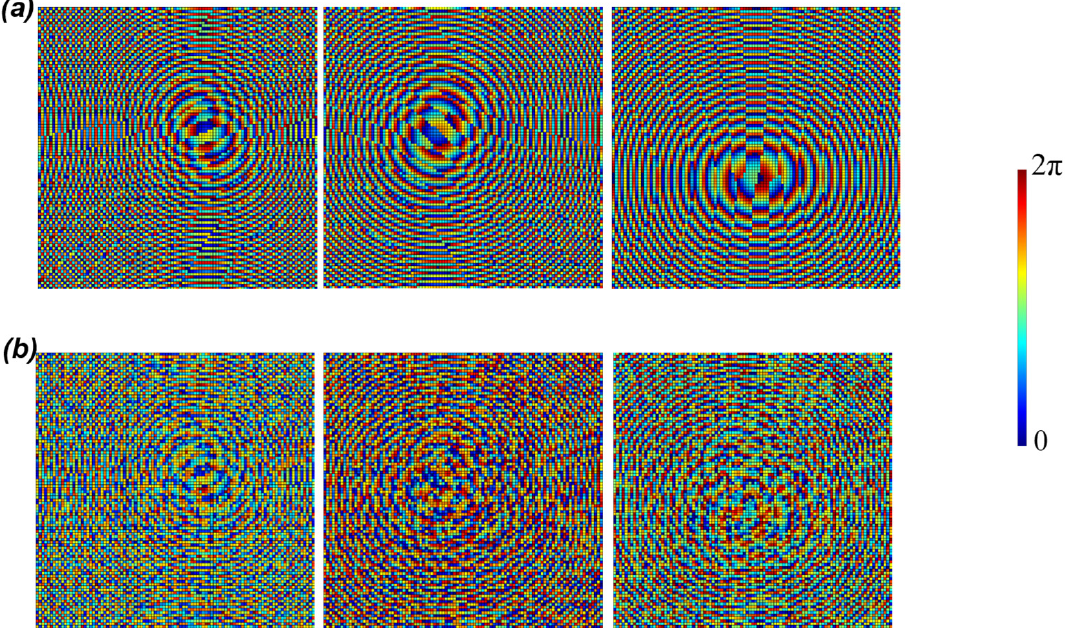
Figure 7. ( a ) From left to right, the ideal phase distributions of the vortex array corresponding to wavelengths B, G, and R, respectively, are shown; ( b ) From left to right, the real phase distributions of the vortex array corresponding to wavelengths B, G, and R, respectively, are shown.